Question: Author a descriptive caption for the visualization shown.
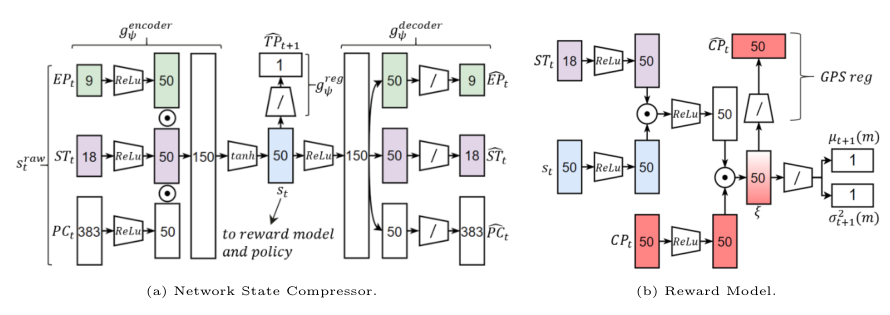
Answer: High dimensional raw network state sraw t P R410 at hour t is compressed using a modular auto-encoder to st P R50. The reward model is an ensemble of probabilistic neural networks. A single component model m is displayed.